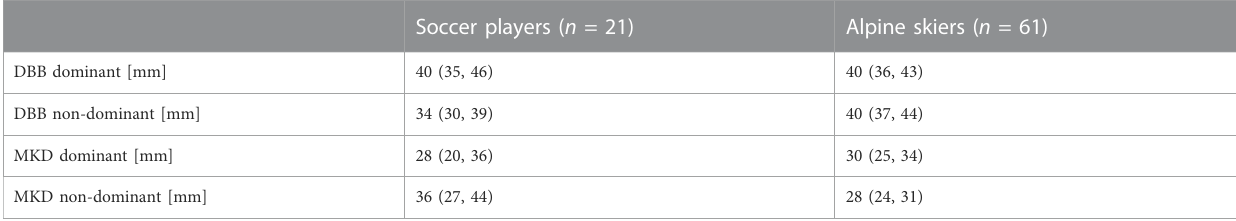
TABLE 2 Medial knee displacement (MKD) and deadbug bridging displacement (DBB) for soccer players and alpine